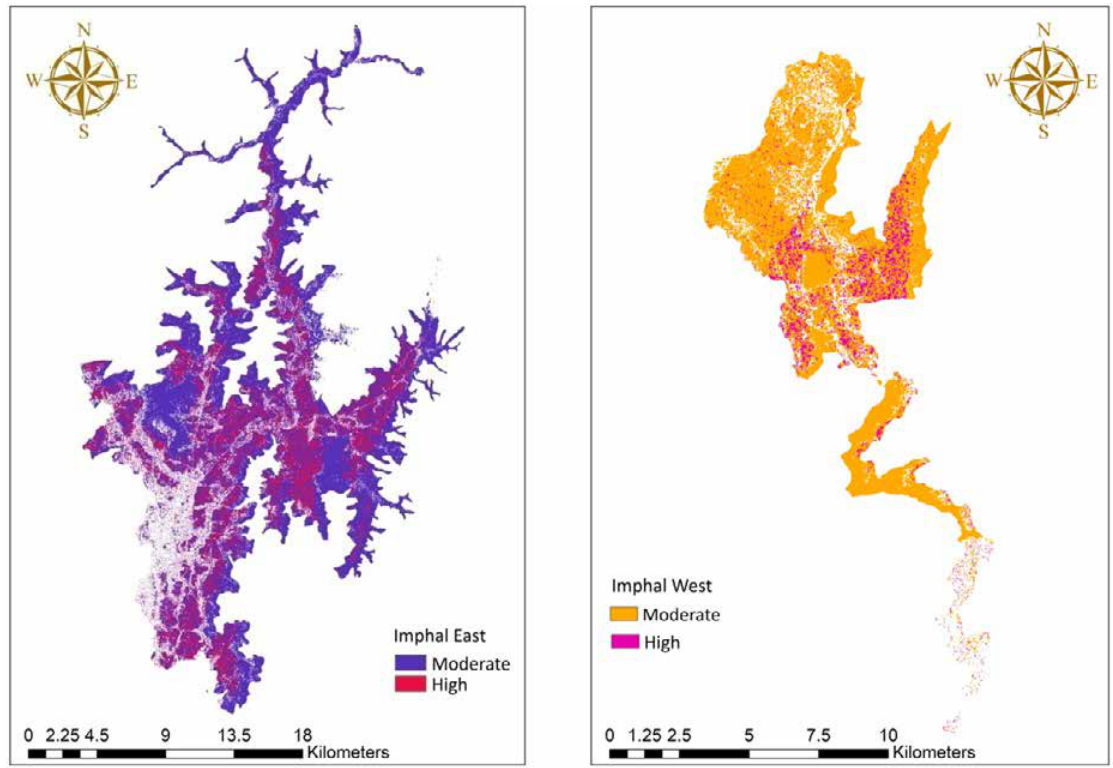
Fig. 7: Agriculture area intercepted by Imphal East and Imphal West district under Imphal-Iril River catchment